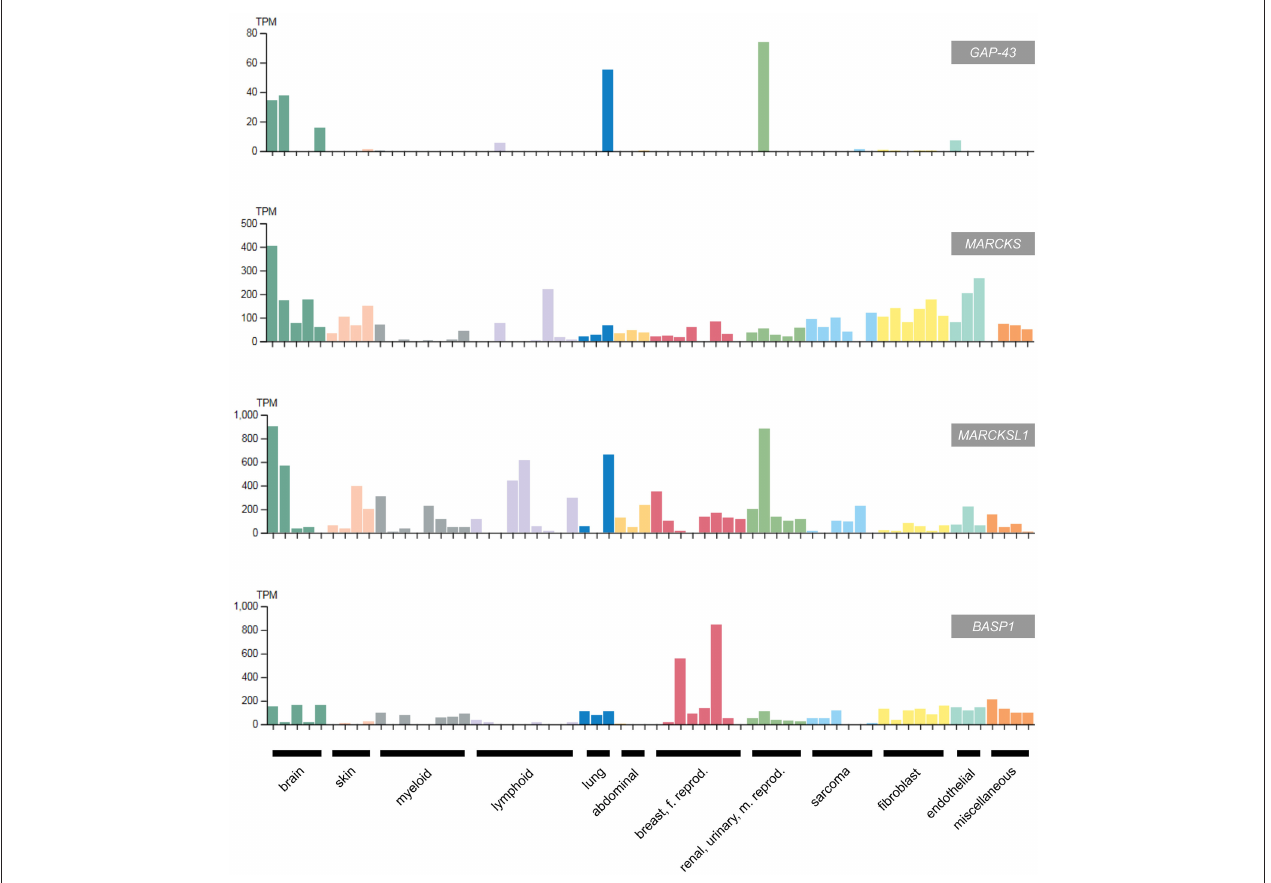
FIGURE 5 | Expression of GAP43 , MARCKS , MARCKSL1 , and BASP1 in selected human cancer cell lines classified according to the original cancer type (93) (adapted from www.protein-atlas.org version 18). RNA expression levels determined by RNA-Seq are given in transcripts per kilobase million (TPM). GAP43 and the MARCKS genes are highly expressed in brain tumor cell lines, whereas BASP1 is suppressed in most cancer cell lines apart from the cervical tumor cell lines HeLa and SiHa. The following cell lines were assessed: brain (AF22, SH-SY5Y, U138-MG, U-251MG, U-87MG), skin (A-431, HaCaT, SK-MEL-30, WM-115), myeloid (HAP1, HEL, HL-60, HMC-1, K-562, NB-4, THP-1, U-937), lymphoid (Daudi, HDLM-2, Karpas-707, MOLT-4, REH, RPMI-8226, U266/70, U-266/84, U-698), lung (A549, HBEC3-KT, SCLC-21H), abdominal (CACO-2, CAPAN-2, Hep G2); breast, female reproductive system (AN3-CA, EFO-21, HeLa, hTERT-HME1, MCF7, SiHa, SK-BR-3, T-47d), renal, urinary, male reproductive system (HEK 293, NTERA-2, PC-3, RPTEC TERT1, RT4), sarcoma (ASC diff, ASC TERT1, LHCN-M2, RH-30, U-2 OS, U-2197), fibroblast (BJ, BJ hTERT + , BJ hTERT + SV40 Large T + , BJ hTERT + SV40 Large T + RasG12V, fHDF/TERT166, HBF TERT88), endothelial (hTEC/SVTERT24-B, HUVEC TERT2, TIME), miscellaneous (BEWO, HHSteC, HSkMC,